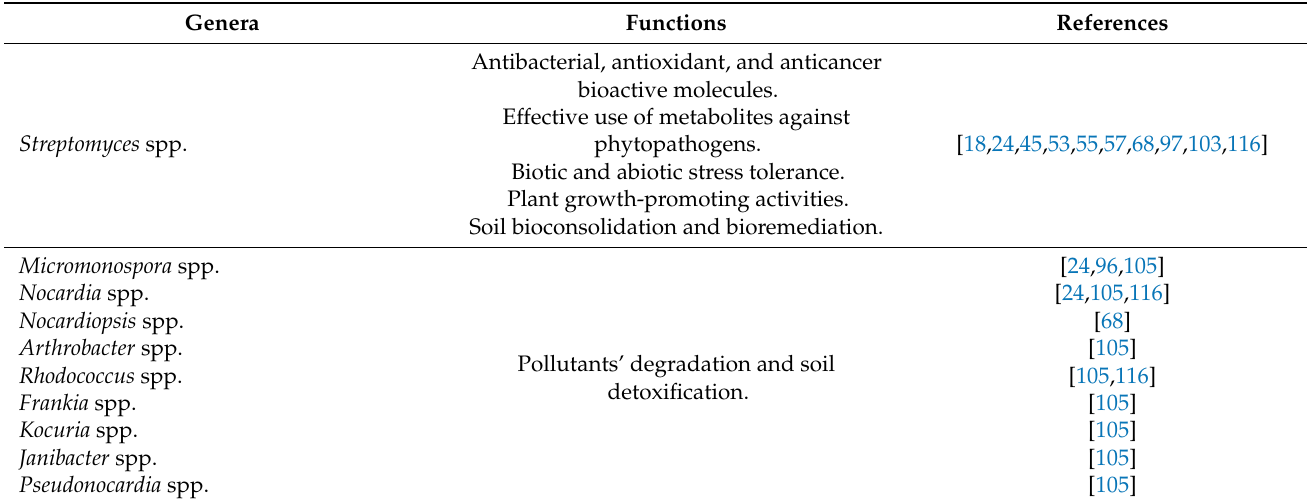
Table 3. Summary of the functions of culturable genera actinomycetes isolated from caves.